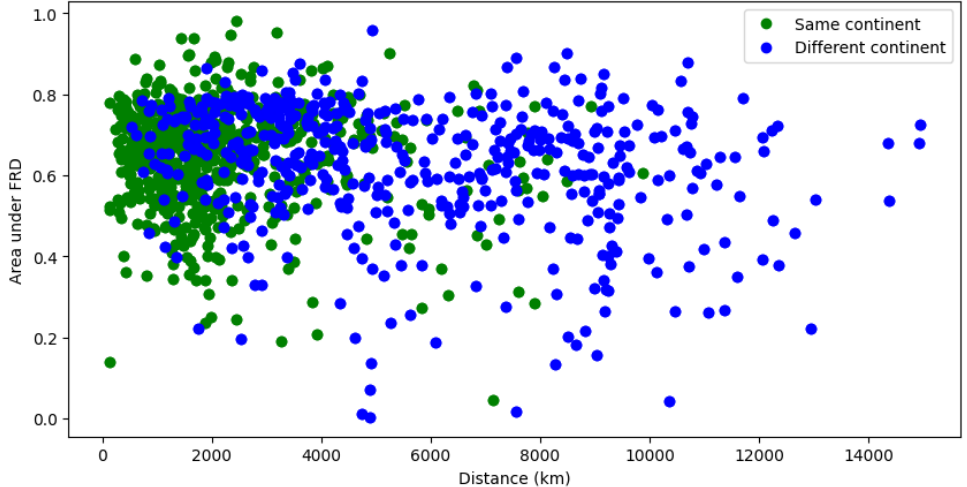
Figure 8. Distance comparison against area under FRD for all country